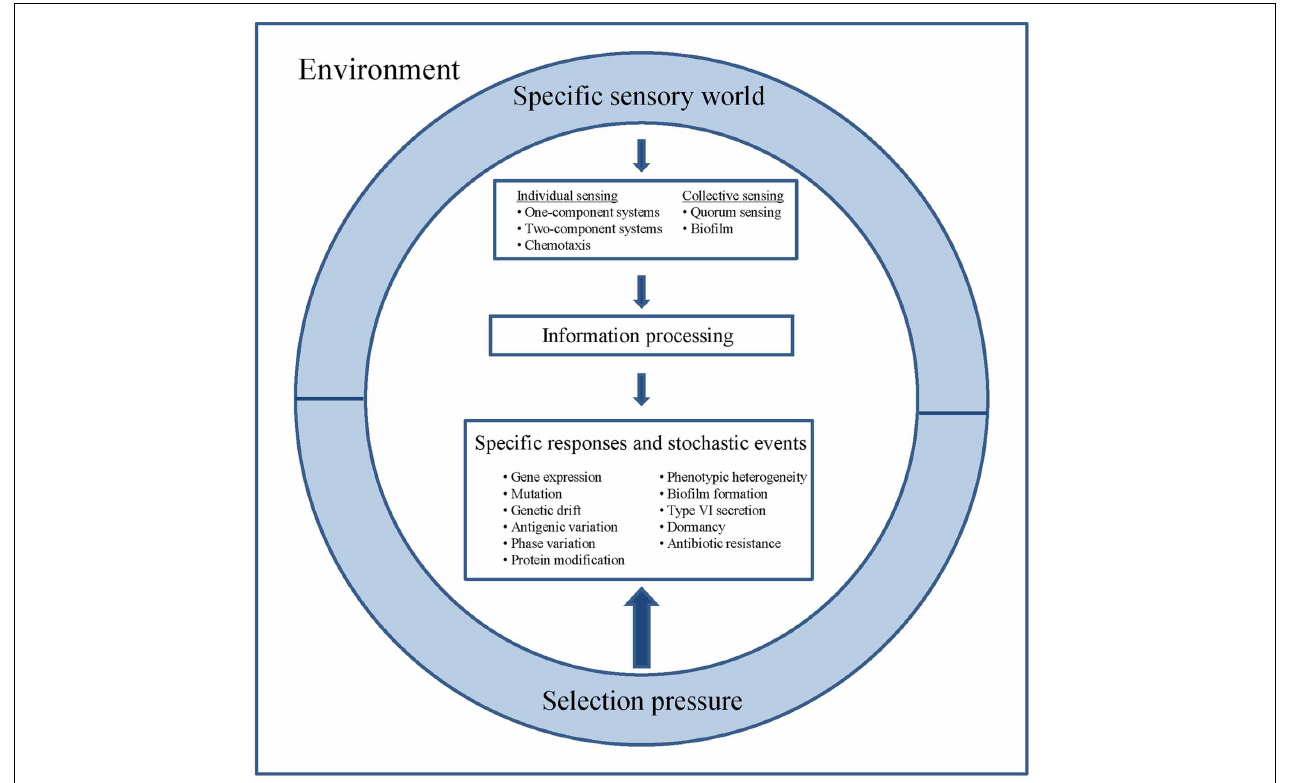
FIGURE 1 | Perception, information processing, specific responses and stochastic events of bacterial pathogens. Different species inhabit different sensory worlds to which they respond as individual cells and as cooperative consortia. The inner- and